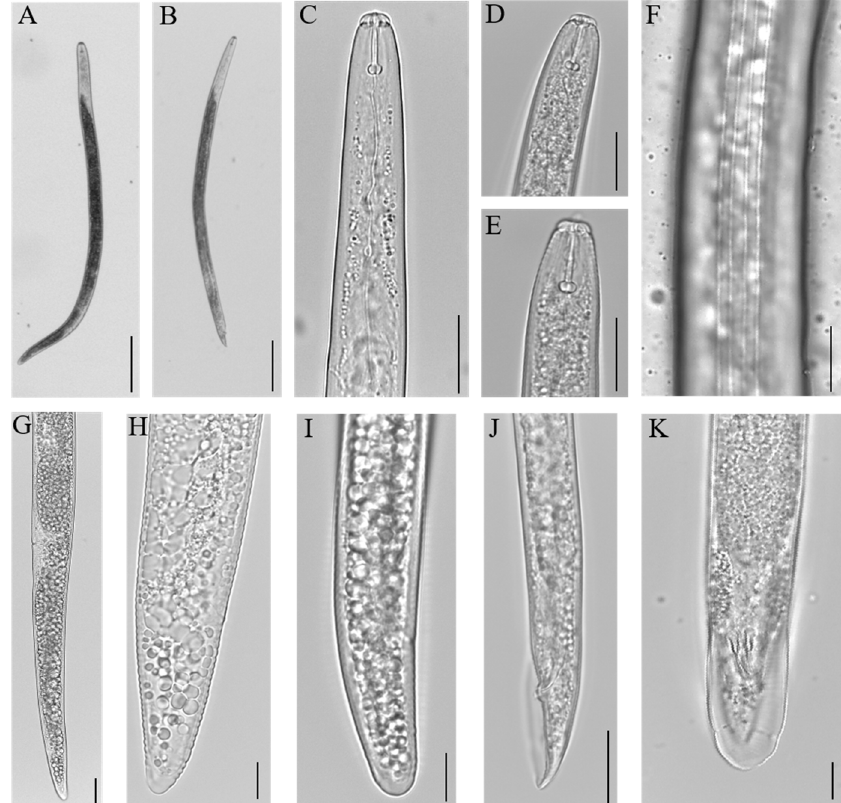
Figure 1. Pratylenchus penetrans specimens from Portuguese isolates: A —Entire female body, B — entire male body; C – E —anterior region; F —lateral field; G —female posterior region showing vulva; H , I —female tail variability; J —male posterior region; K —male tail (ventral side). Scale bars A , B : 100 μ m; C – E , J : 20 μ m; F – I , K :10 μ m. Table 1. Morphometric characters of Pratylenchus penetrans females from Portugal. All measurements are in μ m. Data are means of 10 nematodes ± standard deviation (range). In each row means followed by the same letters do not differ significantly at p > 0.05, according to the Fisher Least Significant Difference test .